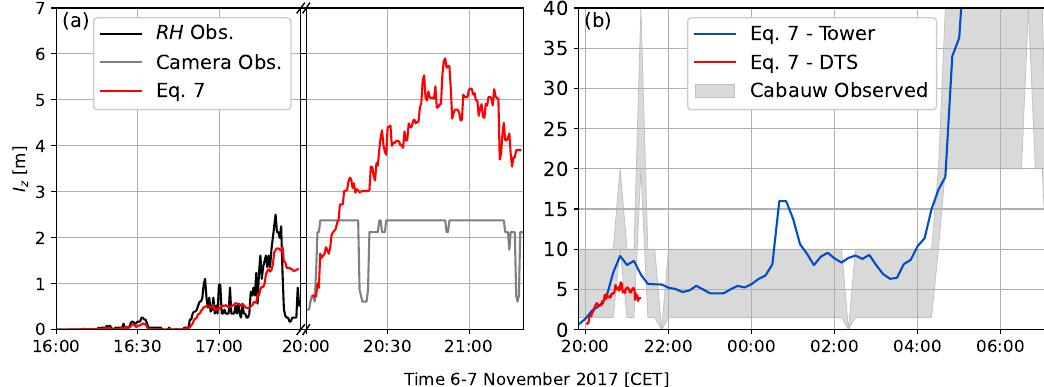
Figure 5. Observed fog height compared with the height estimated by forward integration of Equation (7). ( a ) High-resolution comparison using distributed temperature sensing (DTS)-estimated saturation (i.e., RH = 99% as the interface (left) and the camera-derived observations of fog depth. ( b ) Comparison against the fog depth observed along the Cabauw tower. Note, the camera is limited to a depth of 2.25 m, and the tower is restricted to discrete heights such that the observed fog depth is between the maximum height of observed fog, and the level